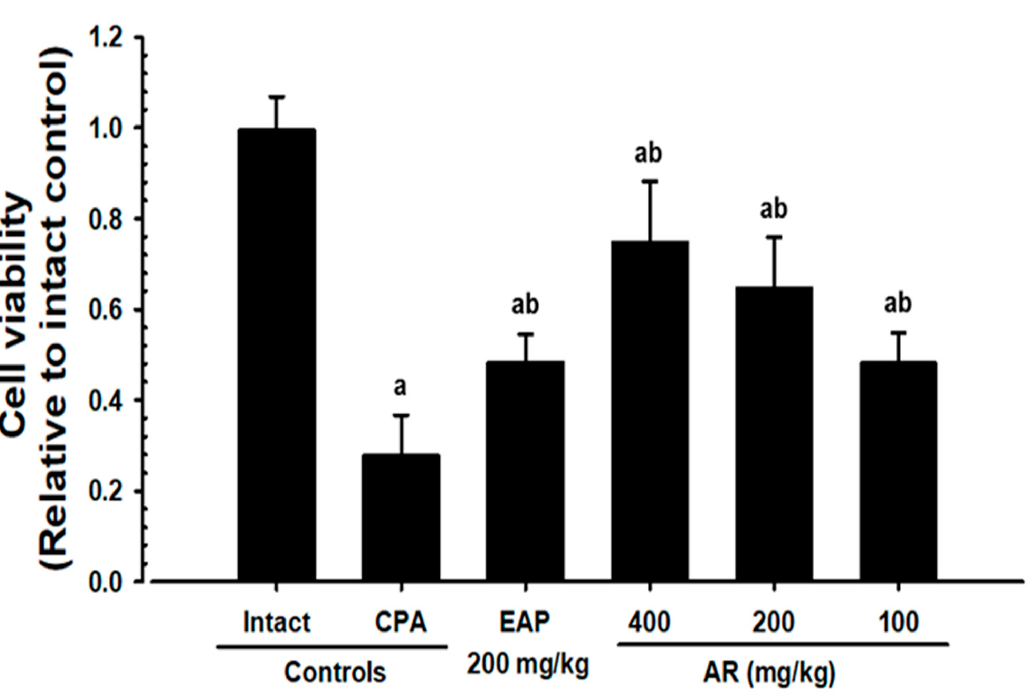
Figure 4. Effects on the LPS-treated splenocyte proliferation. CPA = cyclophosphamide; EAP = exopolymers purified from A. pullulans ; AR = Astragali Radix (Roots of A. membranaceus Bunge) extracts; LPS = Lipopolysaccharide; THSD = Tukey’s honest significant difference; cells were treated with 10 µ g/mL of LPS dissolved in media and incubated for 48 h; a p < 0.01 as compared with intact control by THSD test; b p < 0.01 as compared with CPA control by THSD test. Table 2. Results of the micronucleus assay of bone marrow cells collected from individual intact or CPA-induced immunosuppressed mice at